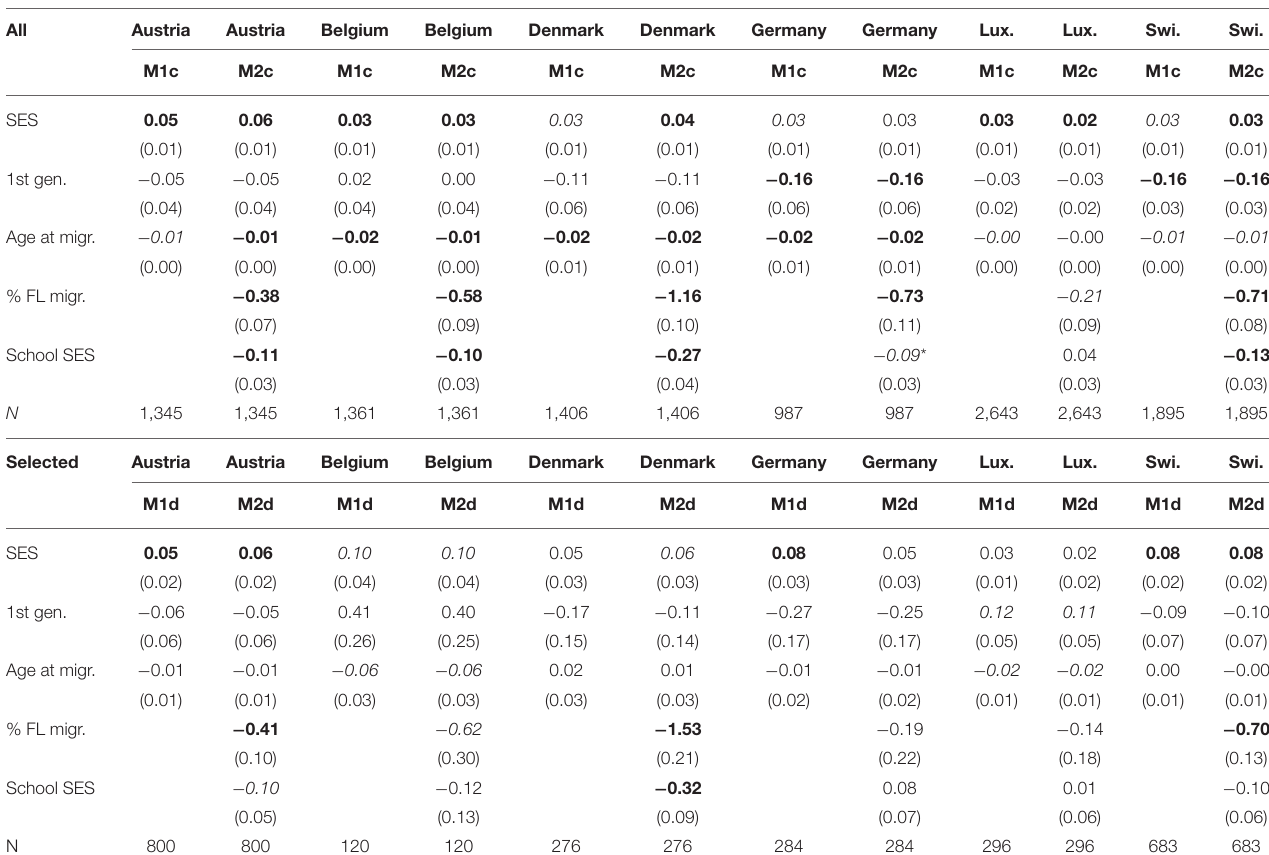
TABLE 4 | Predictors of speaking only the L2 with parents among all (upper panel) and selected group (lower panel).